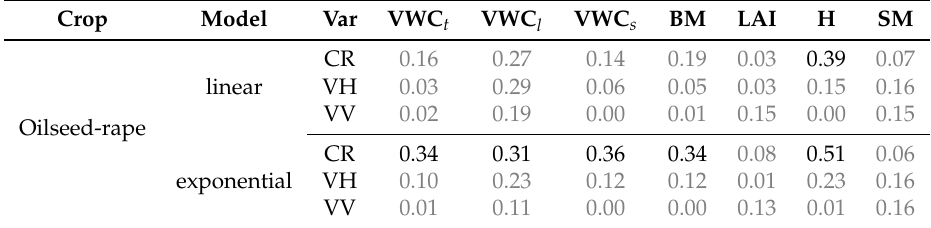
Figure 9. Scatter plot of S1 CR (left), VV (middle) and VH (right) backscatter with in situ measured vegetation variables VWC, BM and Height, and in situ measured soil moisture for the different crop types Oilseed-rape (red), Corn (purple) and winter cereal (green). Table 2. R 2 per crop type (Oilseed-rape, Corn and Winter cereal) between Sentinel-1 CR, VH and VV for variables total VWC (VWC t ), VWC from leafs (VWC l ), VWC from stems (VWC s ), biomass (BM), Leaf Area Index (LAI), plant height (H) and soil moisture (SM) for both the linear and exponential model. In black are significant R 2 values ( p <